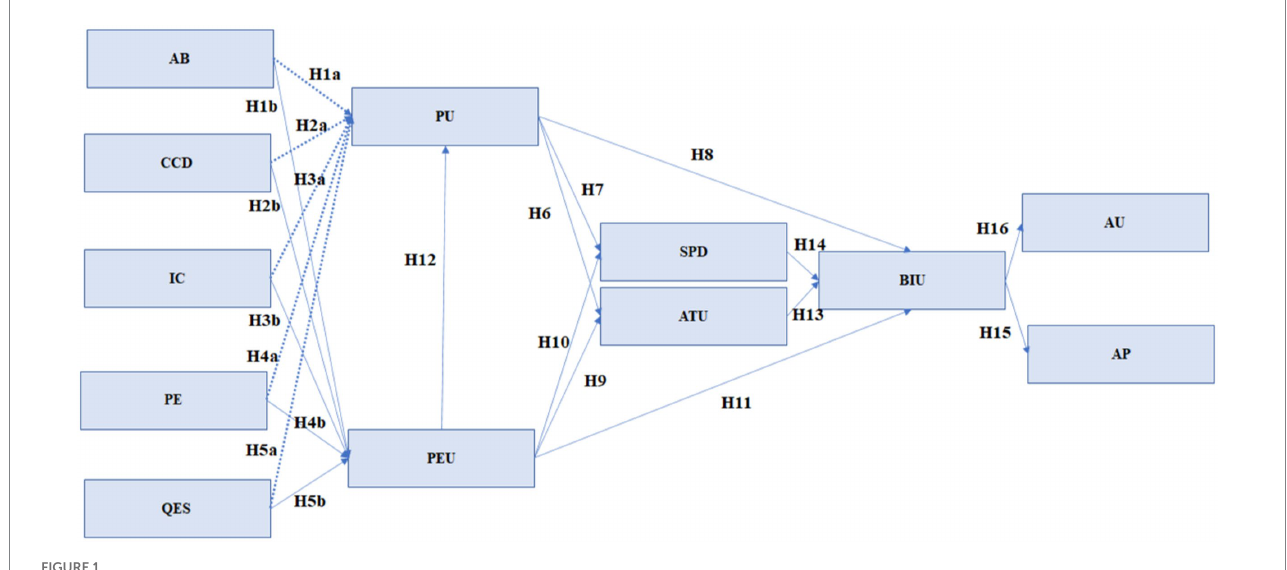
FIGURE 1 Hypothesis